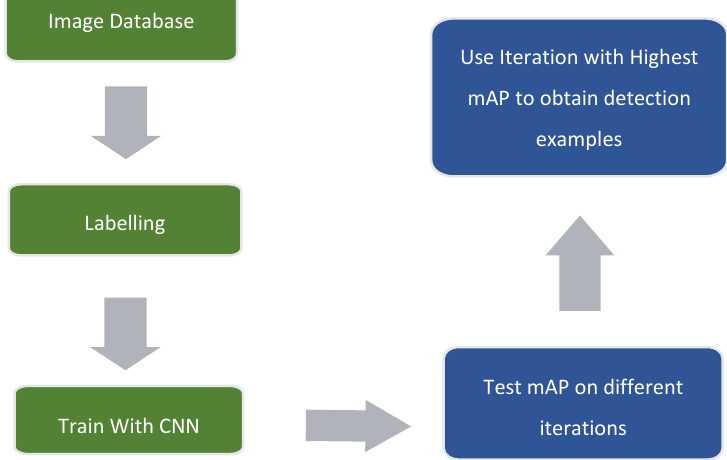
Figure 11. A flow diagram on the use of convolutional neural networks.